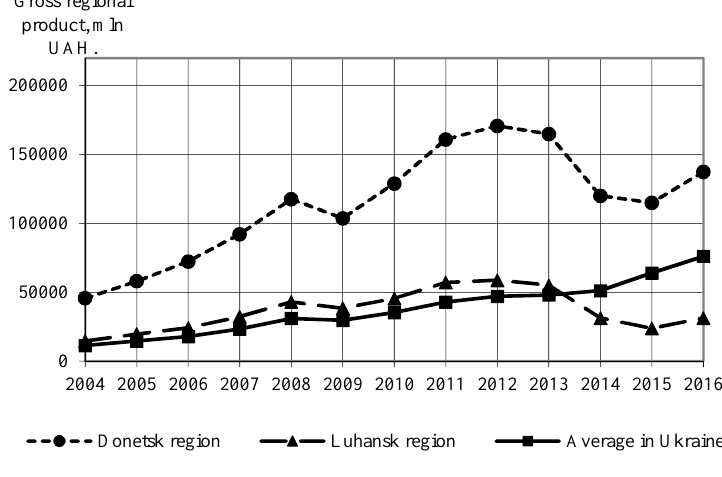
Figure 1. Dynamics of gross regional product of Luhansk and Donetsk regions compared to average value in Ukraine